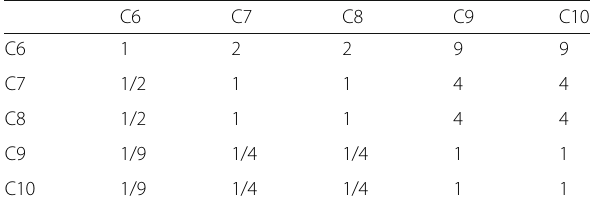
Table 9 The judgment matrix under “ Freight Competitiveness ” .